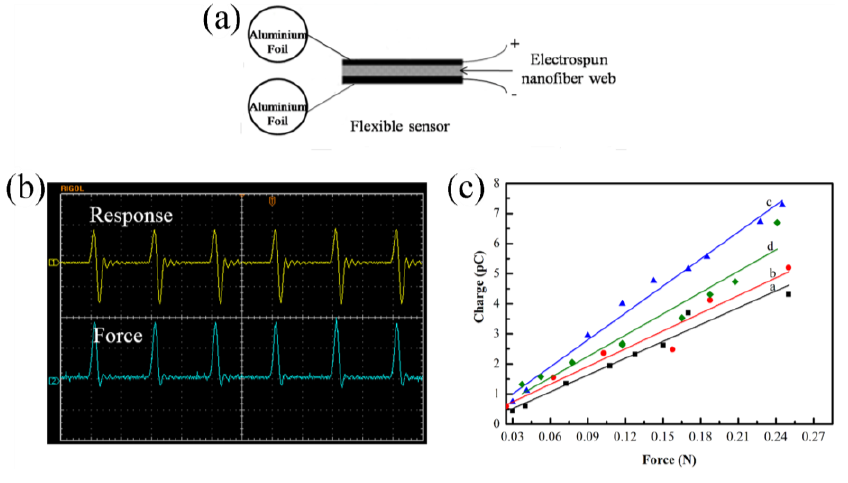
Figure 4. The schematic of the device ( a ) and response of the pressure sensors recorded by oscilloscope ( b ). Plotted line of the response to the exerted force ( c ); a: pure PVDF, b: 0.5 wt% Ag NWs doped PVDF nanofiber web, c: 1.5 wt% Ag NWs doped PVDF nanofiber web, d: 3.0 wt% Ag NWs doped PVDF nanofiber web.